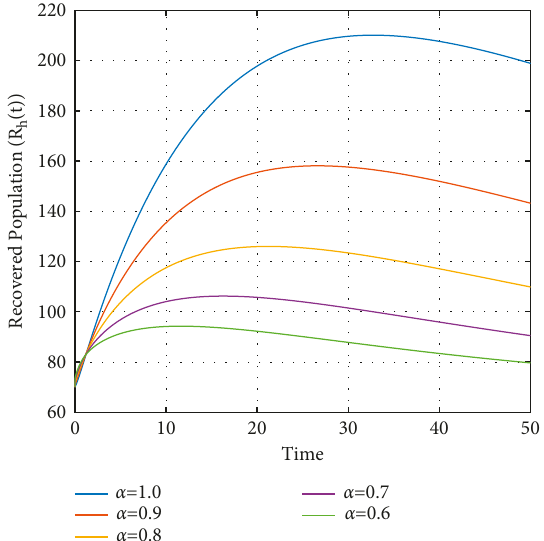
Figure 5: The plot demonstrate the dynamical behaviour of the Figure 7: The graph describes the dynamics of the recovered individuals for different value of the fractional parameter ( σ ) and latent individuals against the epidemic parameters having values: � 0 . 011, ψ � 0 . 016, β � 0 . 01, Λ � 0 . 4, β model parameters value are: Λ � 0 . 4, β 1 3 � 0 . 05, c � 0 . 05, c � 0 . 05, d � 0 . 002, η � 0 . 01, � 0 . 01, d � 0 . 01 c d � 0 . 01 c ψ � 0 . 016, β 1 2 3 1 1 3 � 0 . 06, and α � 0 . 06, and different values of fractional parameter η 2 ( σ ) , while the initial sizes for compartmental population are ( 100 , 90 , 80 , 70 , 60 ) .